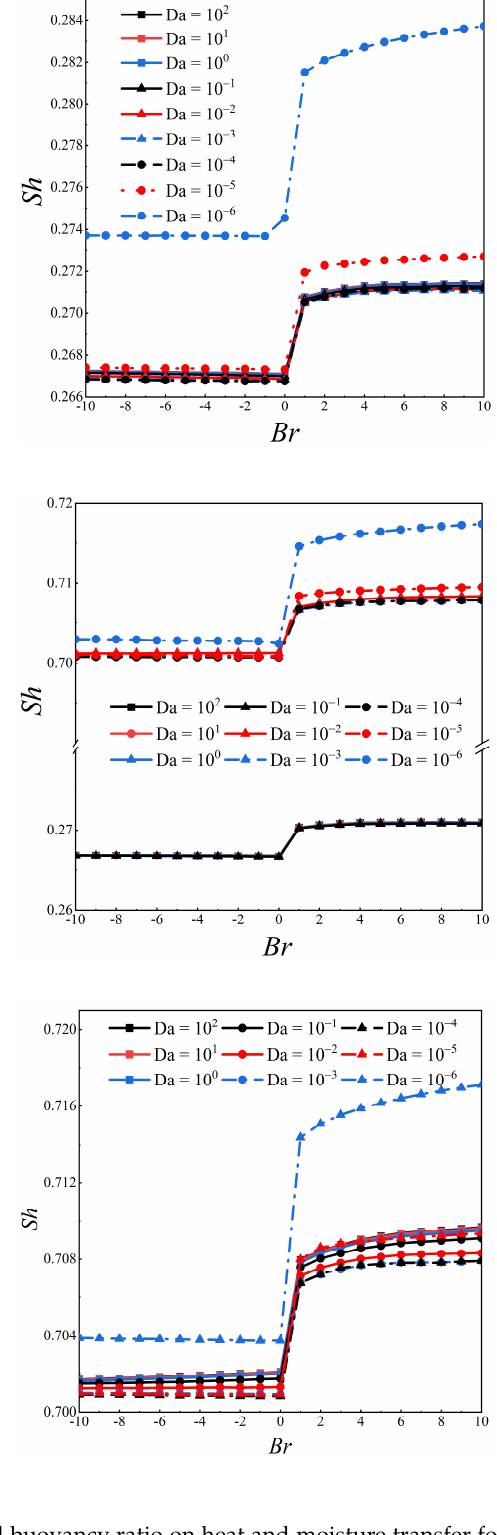
Figure 6. The effect of Darcy number and buoyancy ratio on heat and moisture transfer for three arrangements of porous media at Ri = 1, Kr = 1, and Kc = 1. ( a ) Type A, ( b ) Type B, and ( c ) Type C.